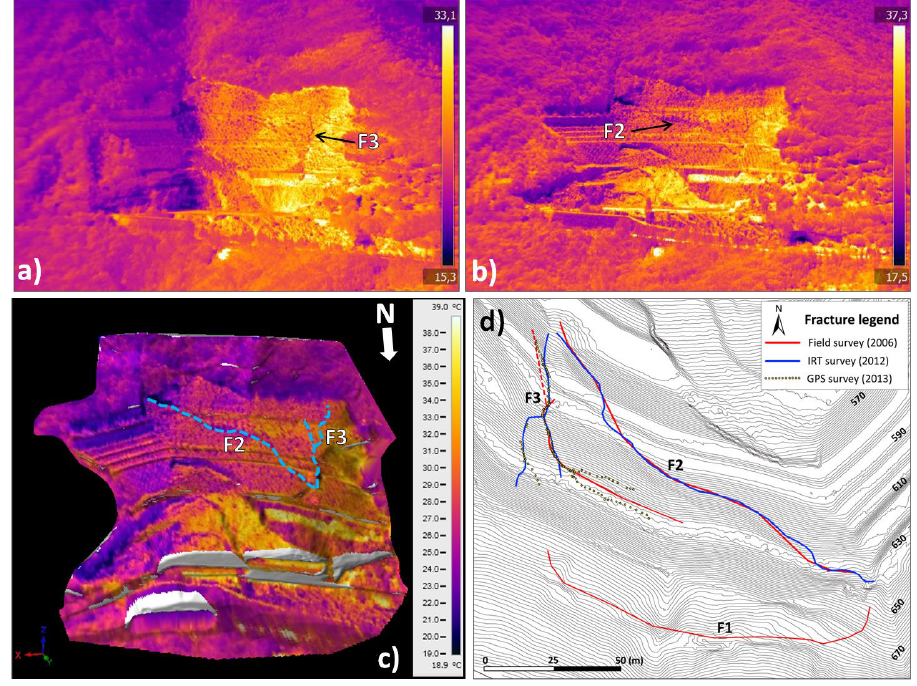
Figure 10. Quarry front thermographic images acquired on July 2012 (( a ); early morning; ( b ); noon); 3D surface temperature map acquired at h 13.00 in the month of July 2012 ( c ) (F1 = downhill boundary; F2 = western boundary; F3 = lateral fracture); ( d ) Fracture map of the rock